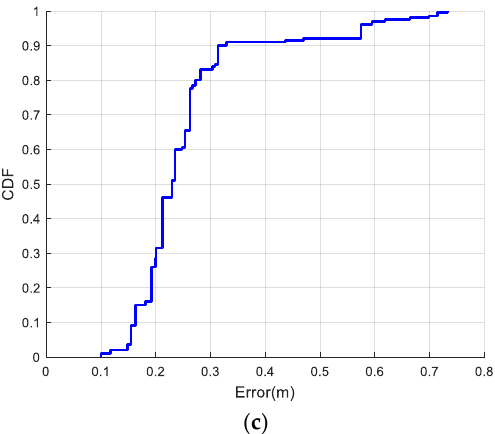
Figure 11. The source rotation test positioning results at the point (2, −1.5). ( a ) Error in the x–direction. ( b ) Error in the z–direction. ( c ) CDF.